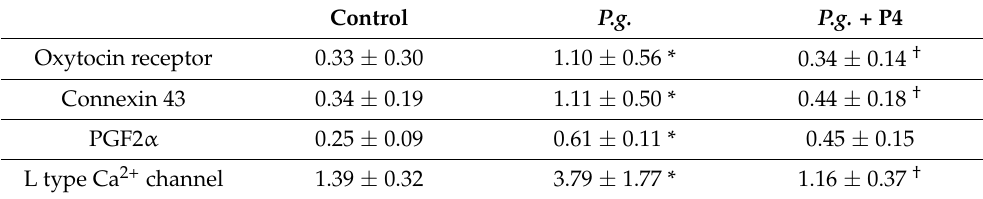
* p < 0.05 (comparison of P.g. with control), † p < 0.05 (comparison of P.g. + P4 with P.g.